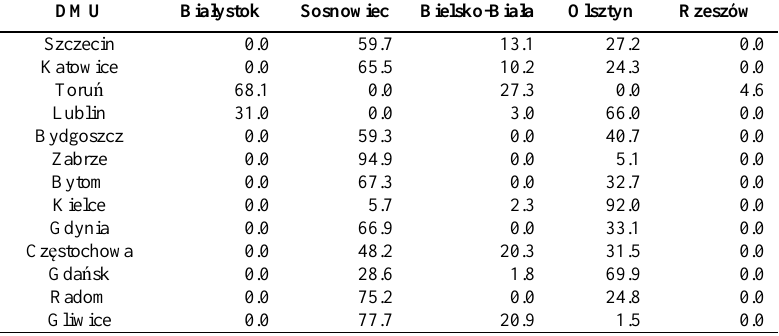
Table 3. Lambda values for inefficient